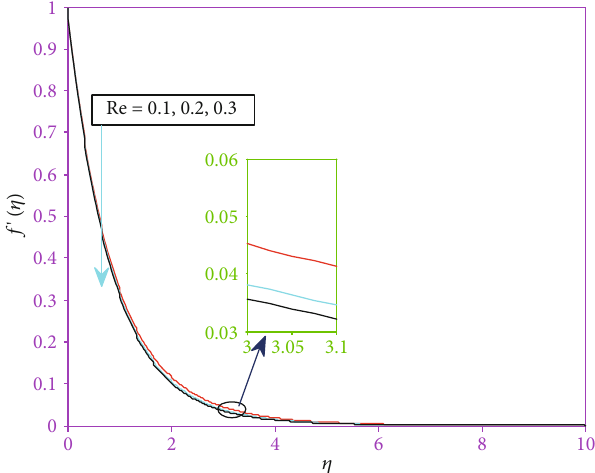
Figure 7: Velocity distribution for di ff erent values of the Reynolds